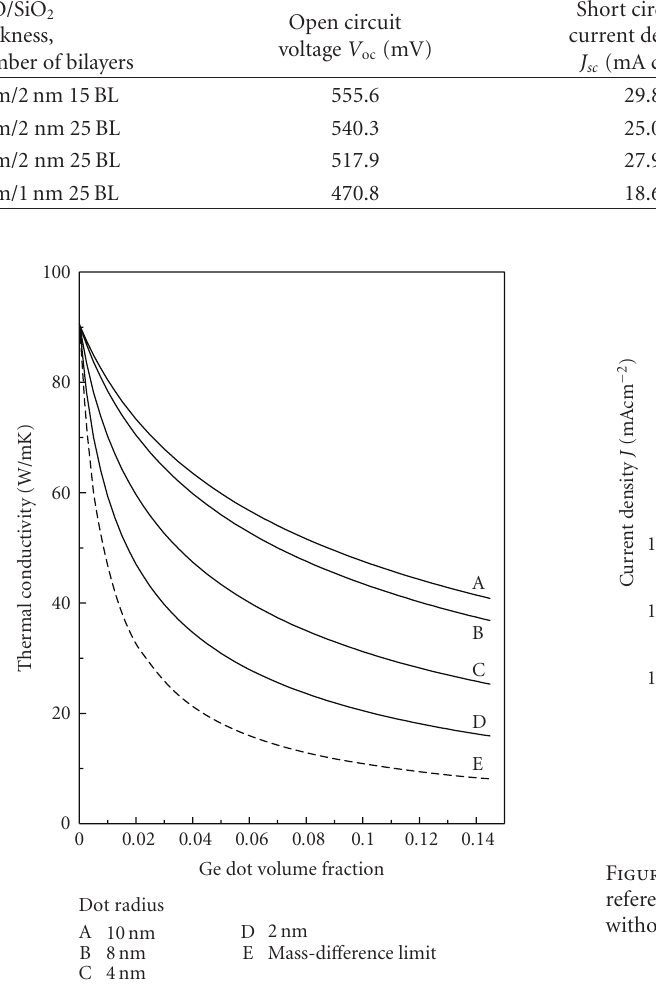
Figure 11: In-plane lattice thermal conductivity as a function of dot volume fraction ( δ ) of Germanium in Si 1 − δ Ge δ alloy. The value of dot size is 10.0 nm, 8.0nm, 4.0nm, and 2.0nm for curve A, B, C, and D, respectively (from [43]).